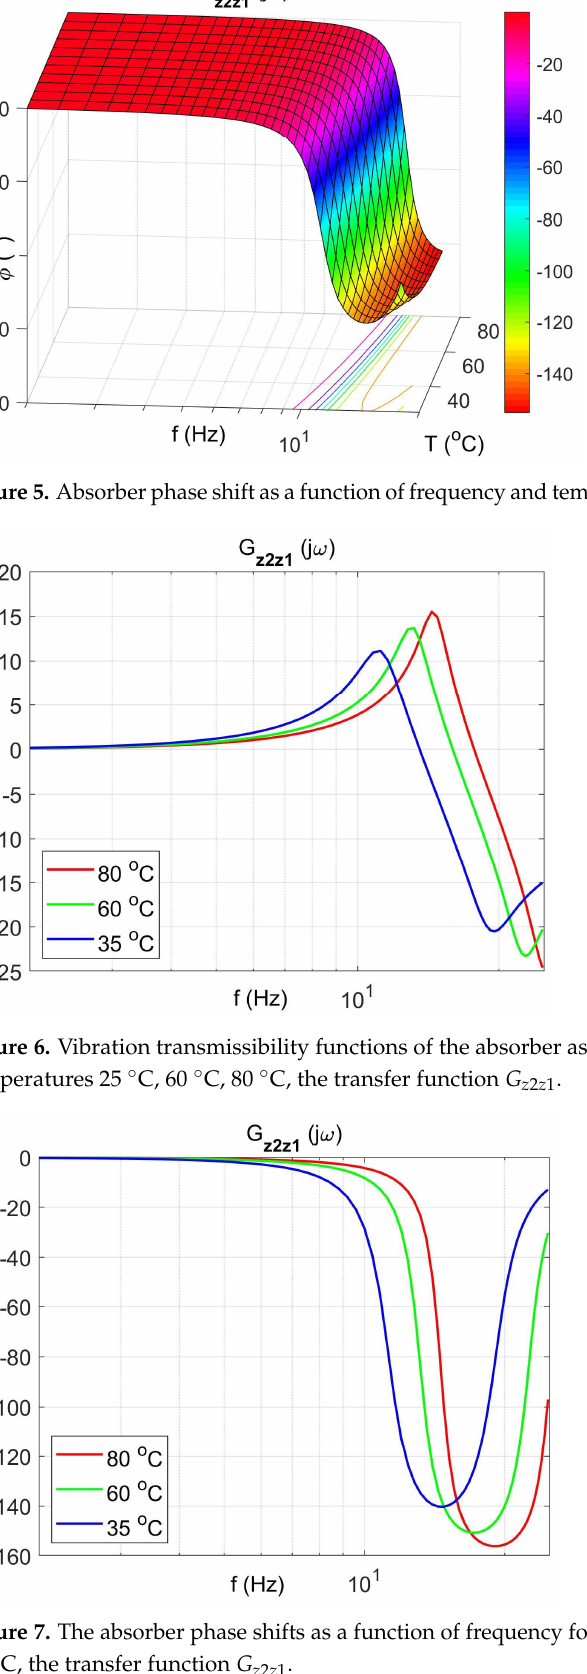
Figure 7. The absorber phase shifts as a function of frequency for selected temperatures 25 °C, 60 80 ◦ C, the transfer function G z 2 z 1